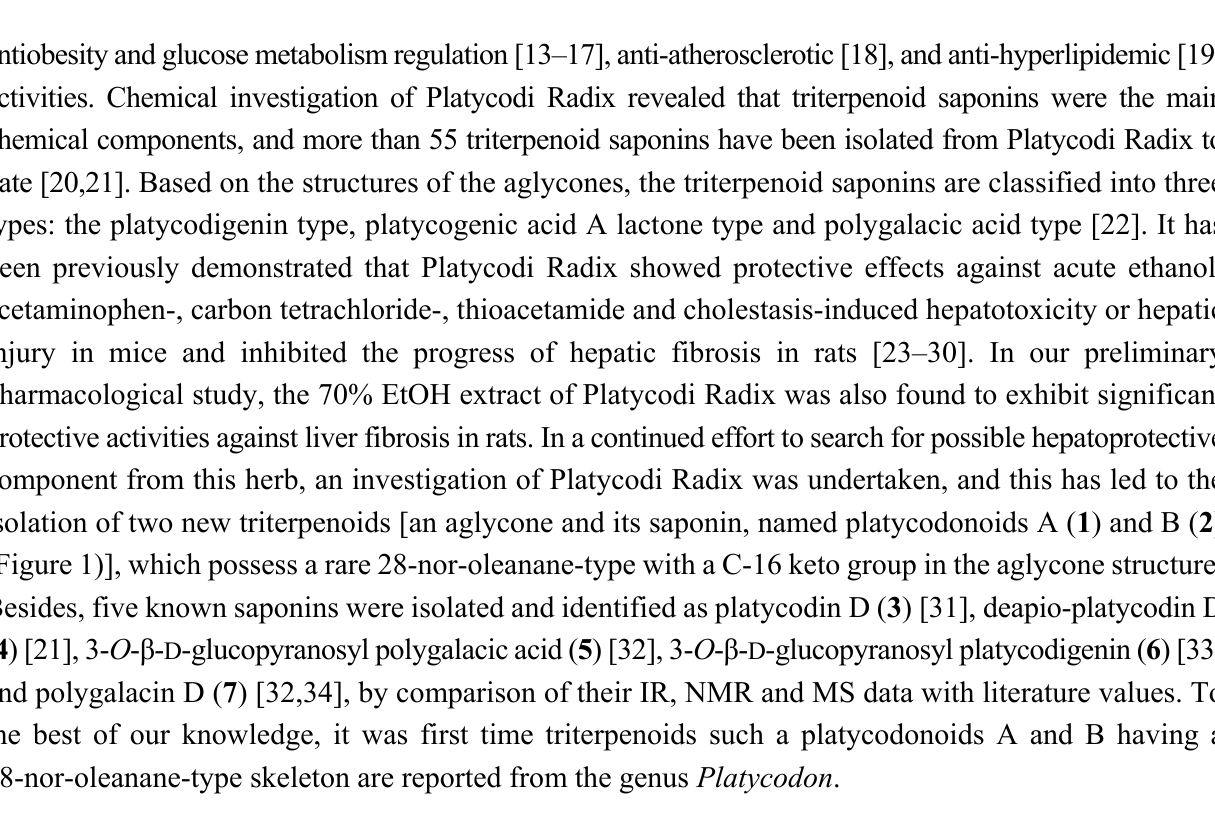
Figure 1. Structures of compounds 1  7